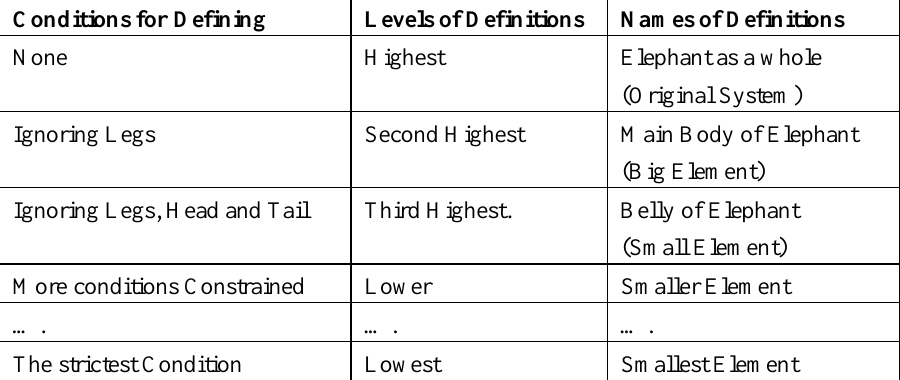
Table 1. System Approach to Defining: An Example.